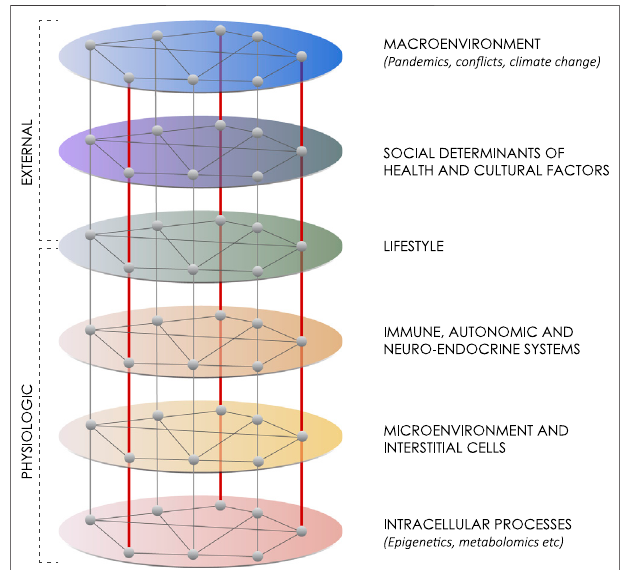
FIGURE1| Lifestyle withinasix-layerhierarchicalnetwork.Thisnetwork diagram summarizes six layers of in fl uences on maintaining health or advancing chronic disease. The fi rst network includes macroenvironment in fl uences like major weather, climate or political events, such as war. The second network includes social determinants of health and cultural factors. The third network includes lifestyle itself made up of physical activity, diet and stress or well-being. The fourth network includes the interacting immune, autonomic and neuroendocrine systems. The fi fth network includes the interactions among interstitial cells within the microenvironment. The sixth network includes intracellular processes, such as epigenetics, genomics, transcriptomics and metabolomics. Although generally in fl uences work from the top down, there can also be an emergence of in fl uence from the bottom